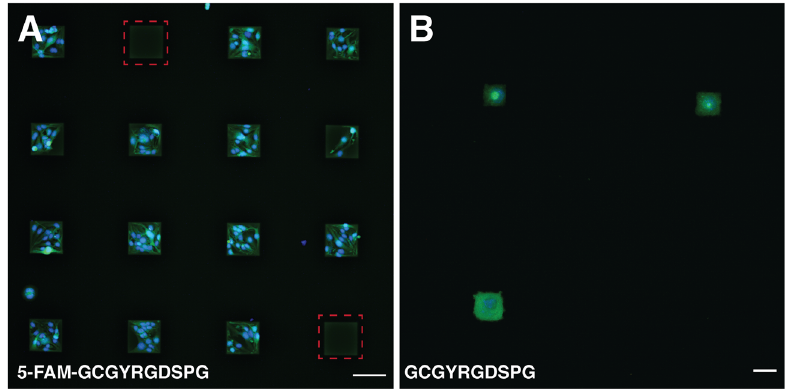
Fig. 3 Fluorescent images showing bEnd.3 cells growing selectively on square peptide patterns on the hydrogel surface on day 1. A 100 × 100 µm 2 5FAM-GCGYRGDSPG patterns. Square green patterns of the RGD are visible, where cells did not adhere (marked in red dashed lines). Scale bar 100 µm. B 25 × 25 µm 2 square GCGYRGDSPG